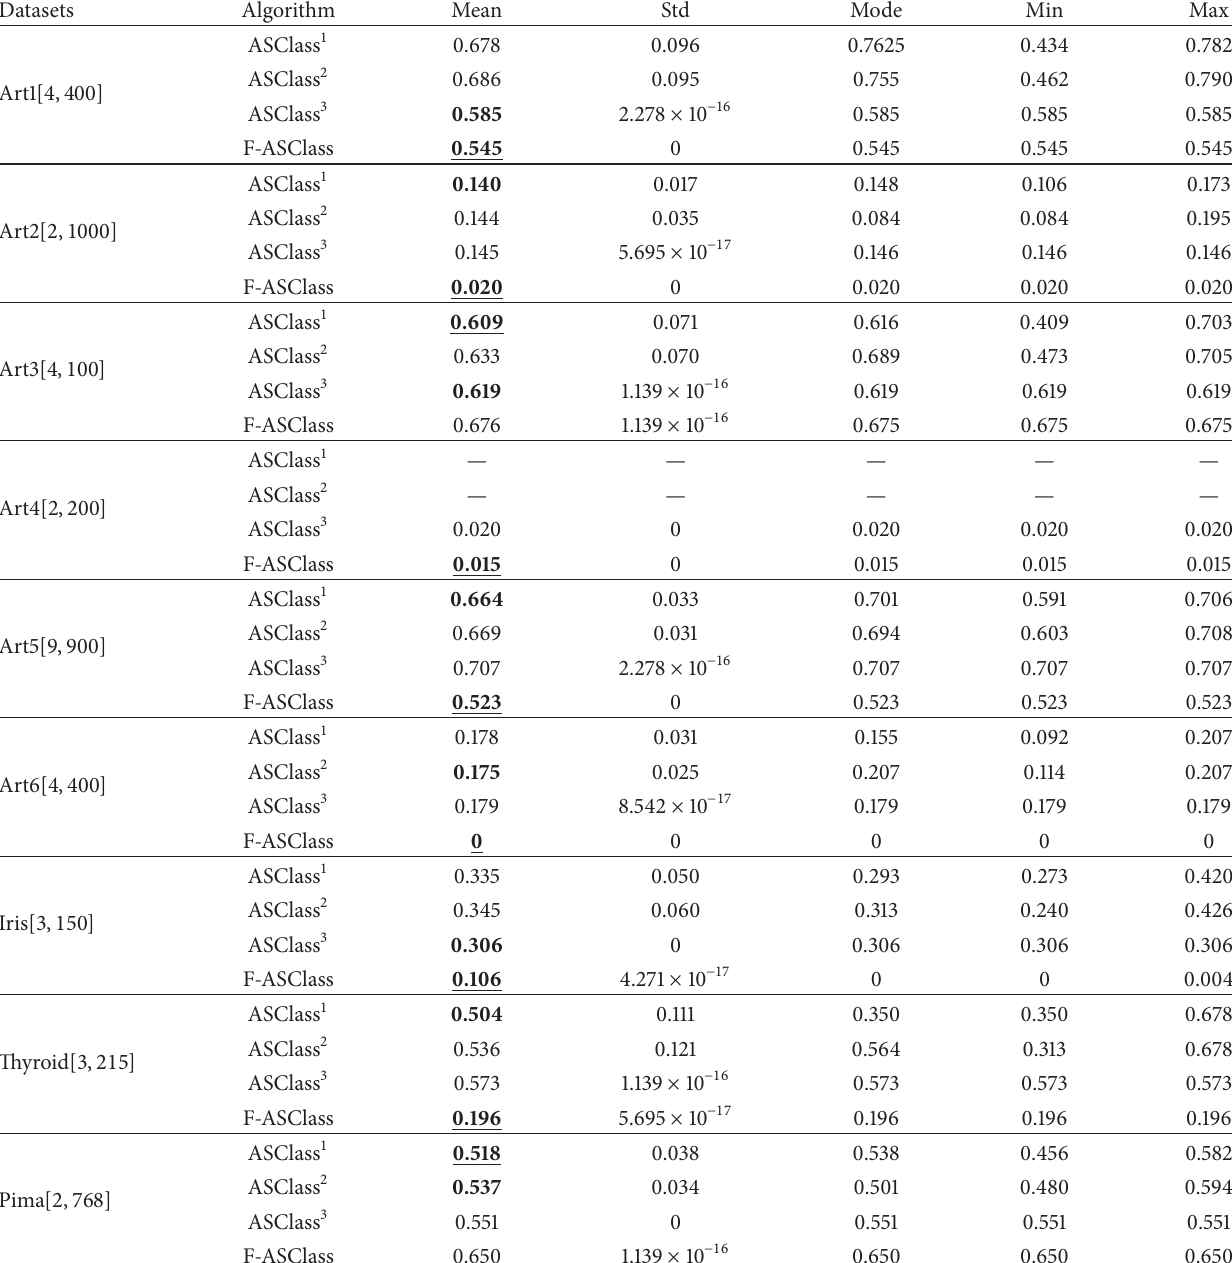
Table 6: Average on 20 trials. Mean, standard deviation, mode, min, and max values of error rate achieved by each clustering (ASClass 1 , ASClass 2 , ASClass 3 , and F-ASClass) algorithm over 20 trials on dataset presented in Table